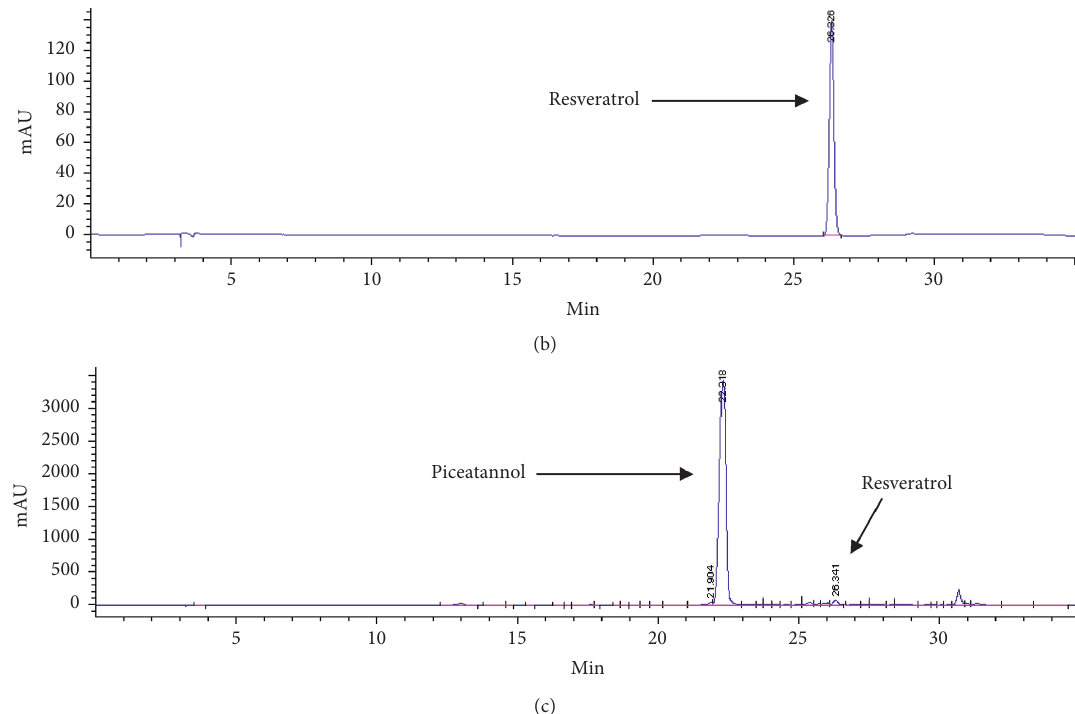
Figure 4: HPLC chromatograms of piceatannol (50 μ g/mL) (a), resveratrol (30 μ g/mL) (b), and C. garettiana extract (5 μ g/mL) (c).